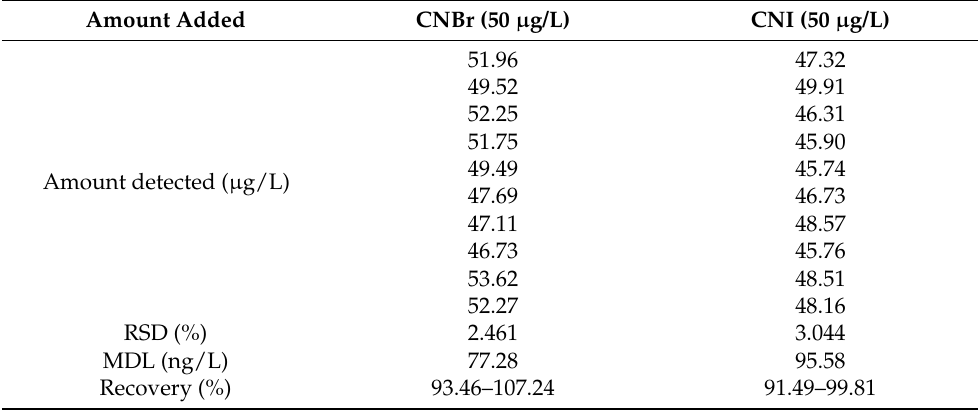
Table 1. Relative standard deviation (RSD), method detection limit (MDL), and